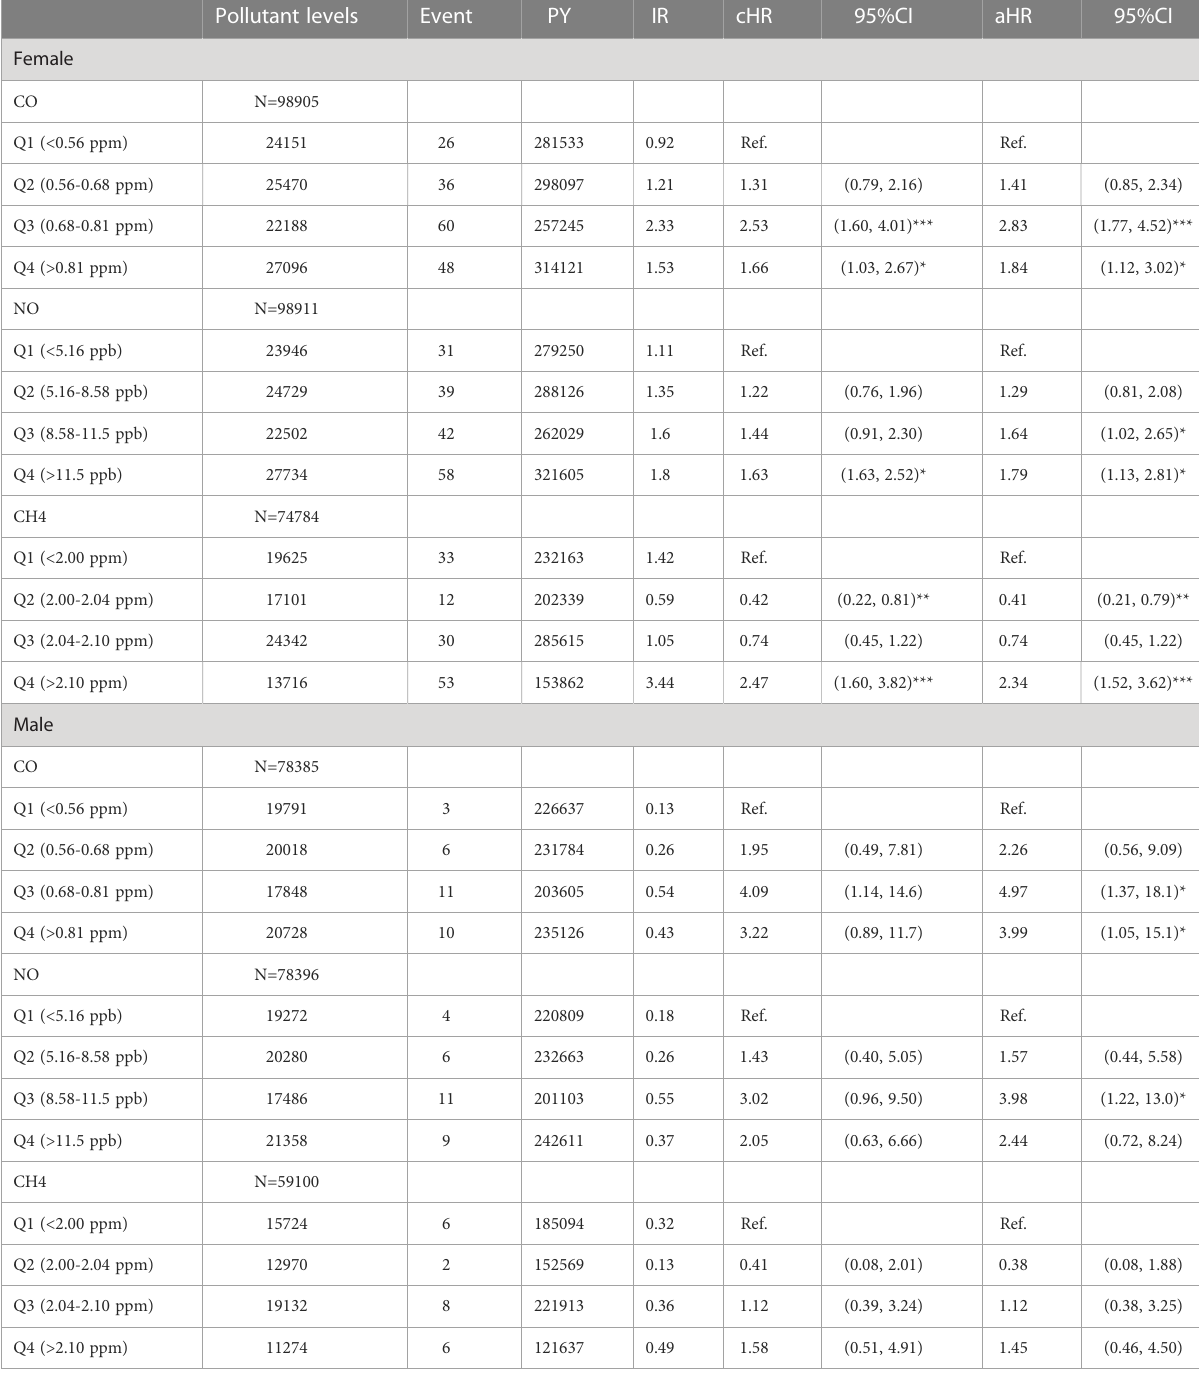
TABLE 3 Incidence and risk of pSS in participants exposed to CO, NO, and CH 4 , as strati fi ed by